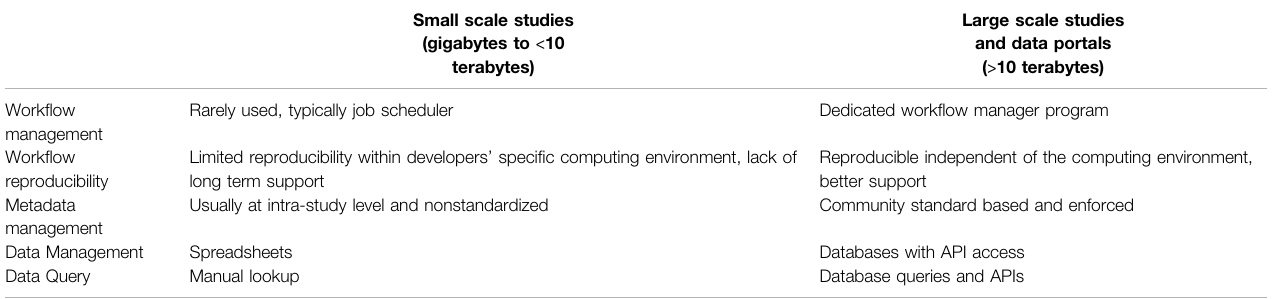
TABLE 1 | Scaling related